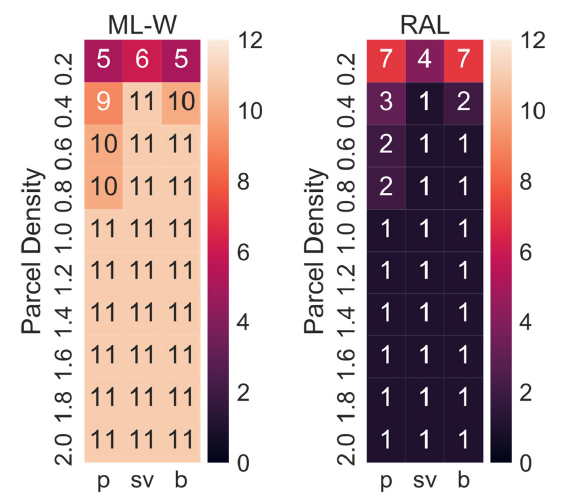
Figure 13. Numbers of times RAL and ML ‐ W were the best options in the sensitivity analysis.